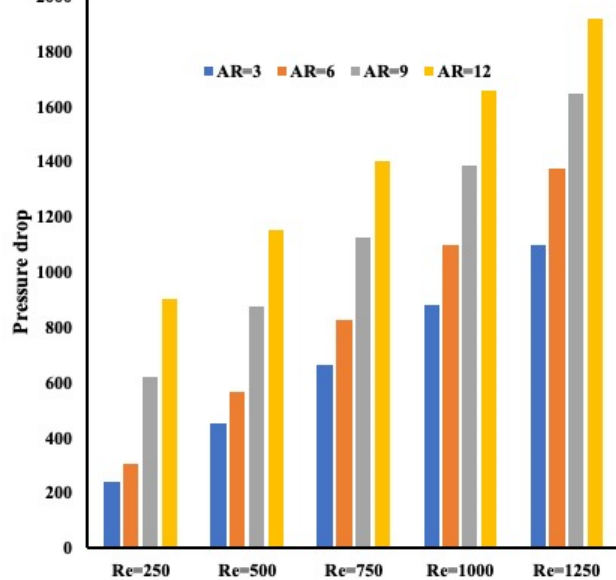
Figure 10. Pressure drop variation for all cases.